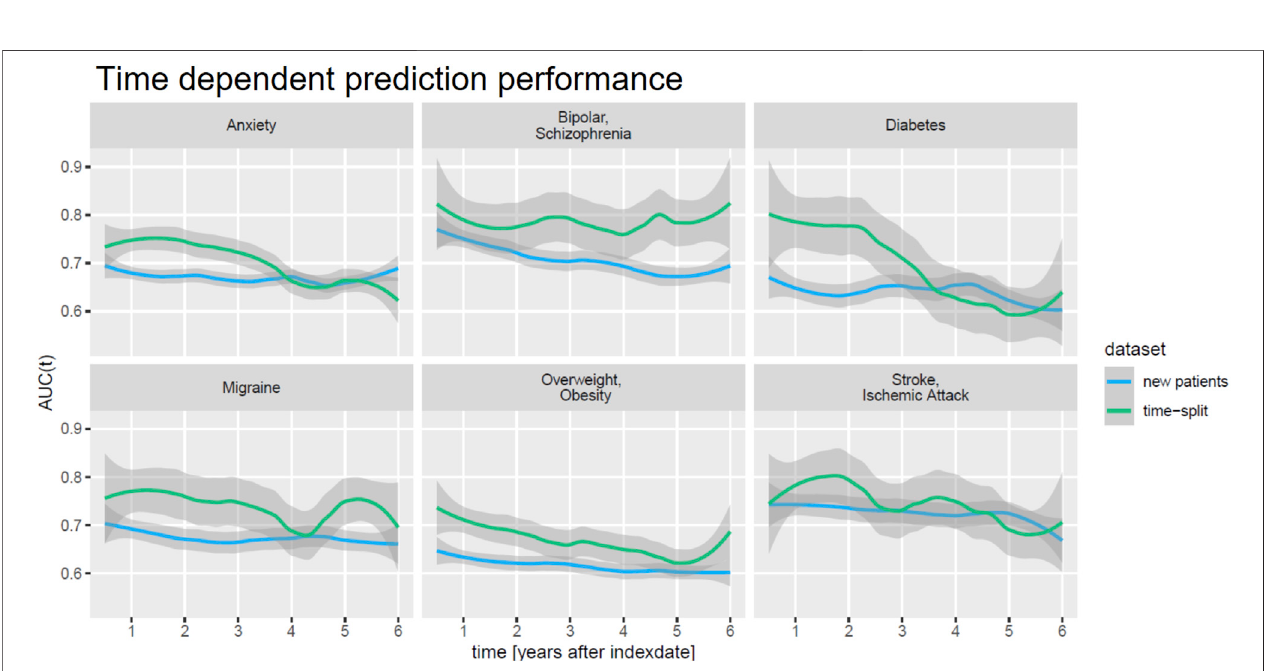
FIGURE 5 | Time-dependent prediction performance (AUC(t)) of DeepLORI on external validation